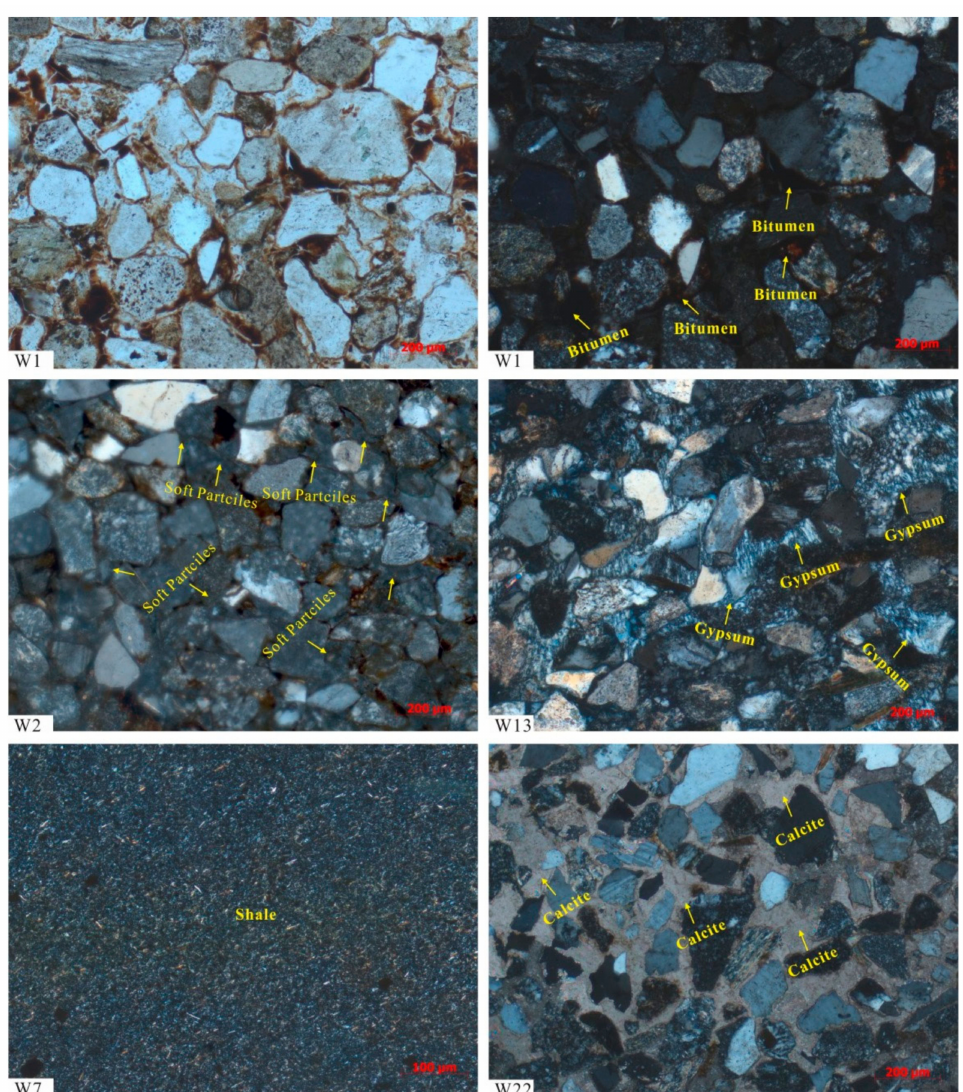
Figure 4. Microscopic characteristics of the facies (W1 includes bitumen; W2 include soft particles; W13 includes gypsum cement; W7 is mudstone; W22 includes calcite